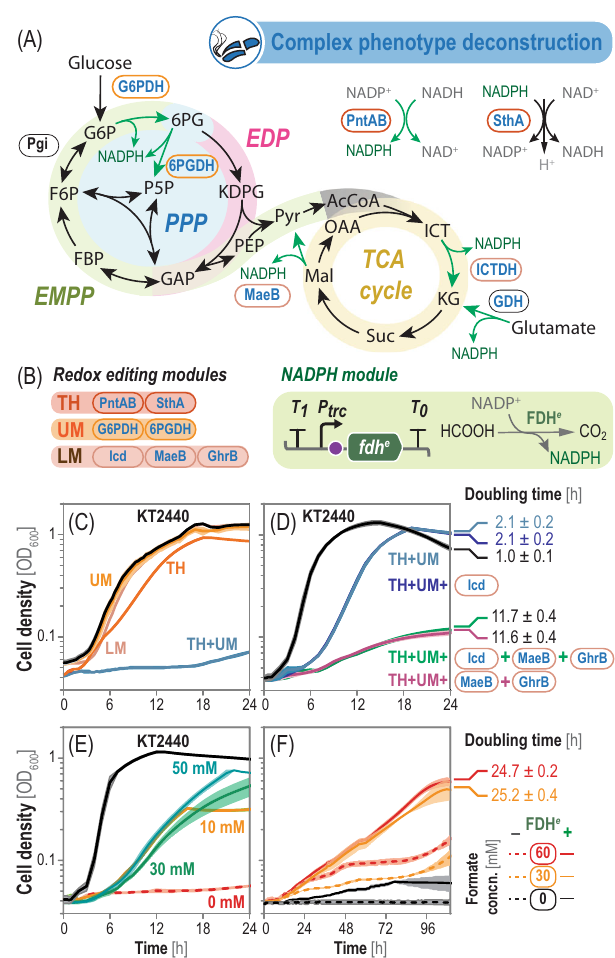
Fig. 6 Modular deconstruction of the NADPH metabolism in P. putida . A Simpli fi ed scheme of central metabolism in P. putida . Four core reactions deliver NADPH, i.e., glucose 6-phosphate dehydrogenase (G6PDH),